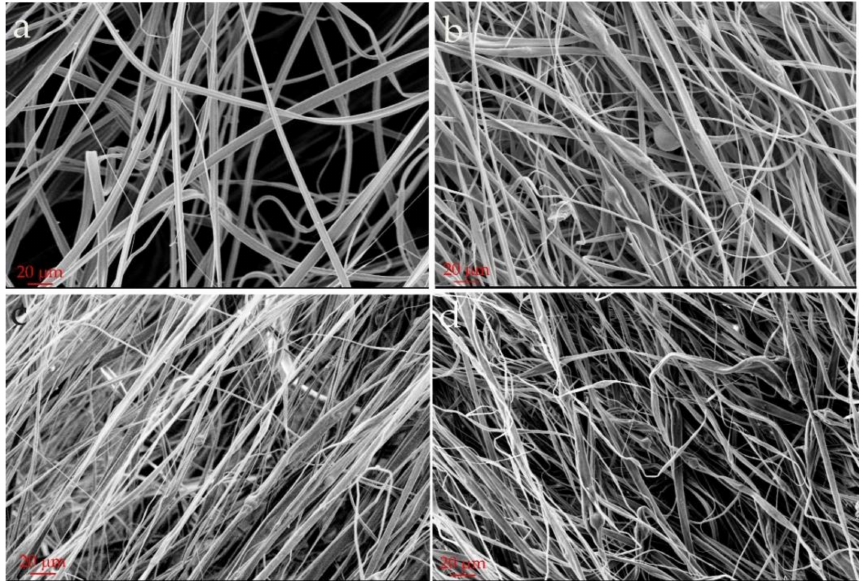
Figure 1. Scanning electron microscopy image of the electrospun fibers: ( a ) Pure polycarbonate; ( b ) Polycarbonate with 10 wt % BNP; ( c ) PC with 15 wt % BNP; ( d ) PC with 20 wt %